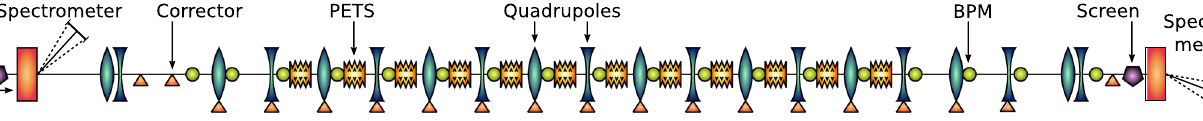
FIG. 2. The current TBL lattice. Quadrupole magnets are shown as blue lenses, dipole magnets as orange rectangles, corrector devices as orange triangles, BPMs as green circles, OTR screens as purple pentagons, and PETS as brown corrugated structures.